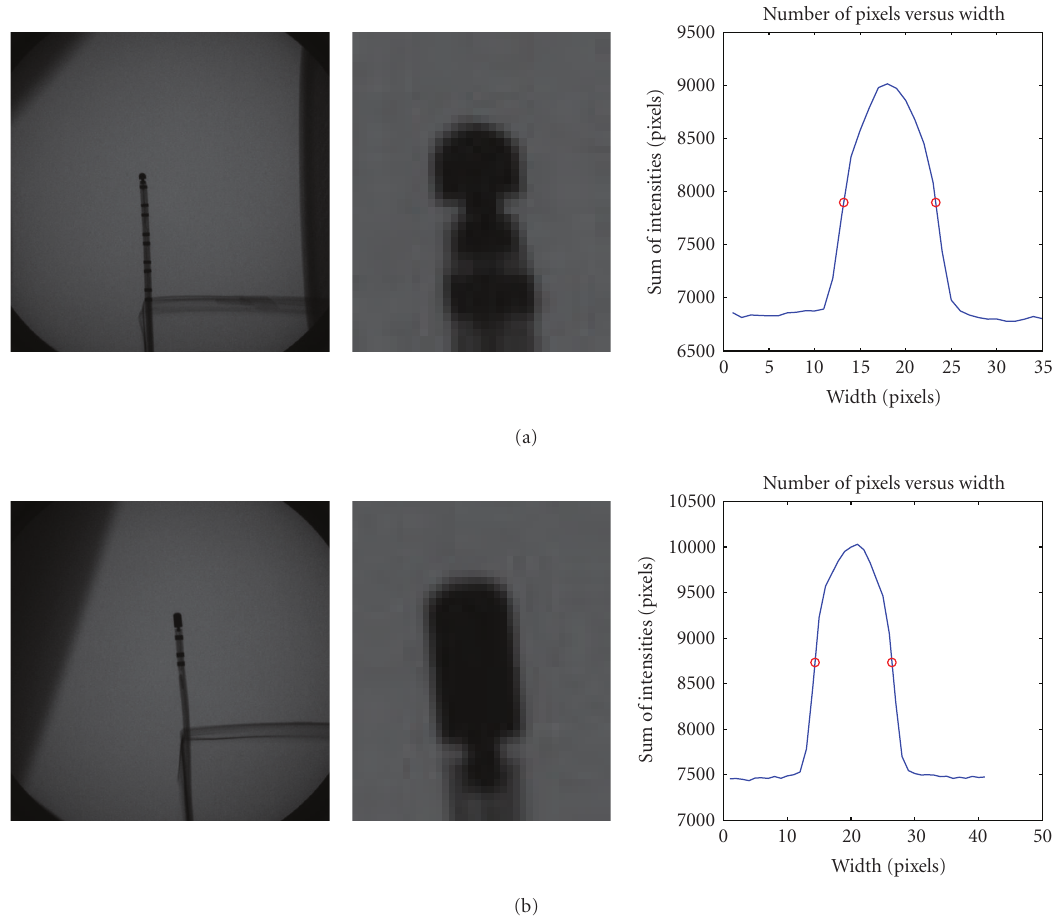
Figure 8: (a) 7-French Catheter with cropped tip electrode and projection of pixels along perpendicular axis. (b) 8-French Catheter with cropped tip electrode and projection of pixels along perpendicular